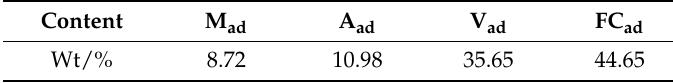
Table 1. Proximate analysis of the experiment